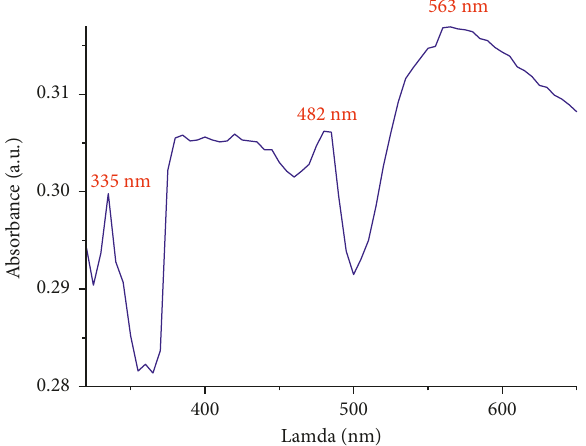
Figure 4: UV-vis absorption spectrum of synthesized nanocomposites.